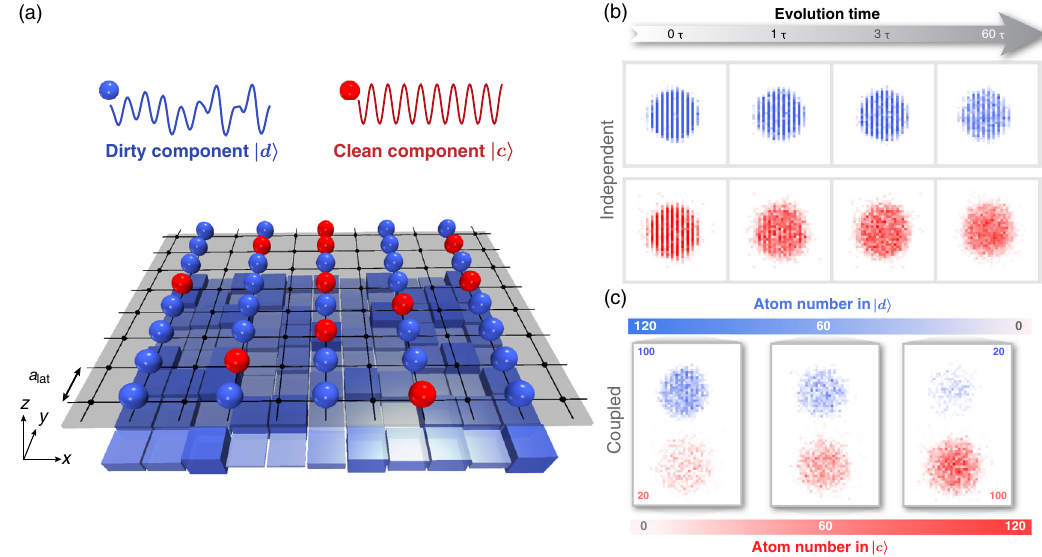
FIG. 1. Schematic description of the experiment. (a) Illustration of the two-component mixture at the beginning of the experimental sequence. The system consists of a square optical lattice with species-dependent disorder in which two different bosonic hyperfine spin states are prepared. The clean component (red, j c i ) experiences only the lattice potential, while the dirty component (blue, j d i ) is additionally affected by a random on-site potential (blue boxes of different lightness). The initial state is prepared with a short-scale density modulation along the x direction. (b) Dynamics of the mean density distribution for systems prepared independently with only either one of the two components. The dirty component partially preserves the initial-state density modulation for a sufficiently high disorder strength (in blue, for Δ ¼ 28 J ), which is a signature of the breakdown of ergodicity and the formation of a MBL phase. The clean component j c i , in contrast, relaxes in a few tunneling times to a state with no clear density modulation (in red). (c) Mean state- selective density distribution of a mixture after a long evolution time. The measurements are taken after 281 τ evolution for three exemplary component